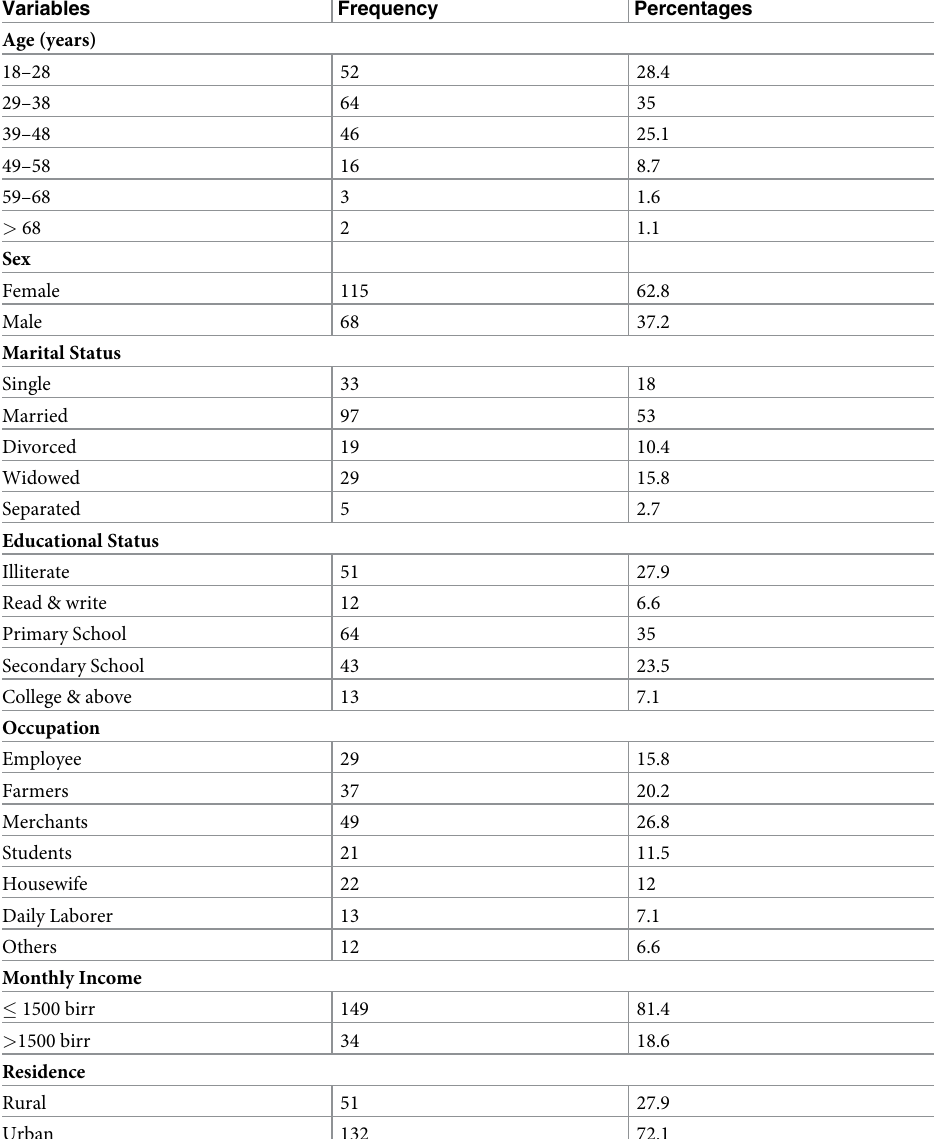
Table 1. Socio-demographic characteristics of HIV-infected patients attending second-line ART at Ambo General Hospital and Nekemte Referral Hospital, Western Oromia, Ethiopia from September 1, 2017, to November 30,